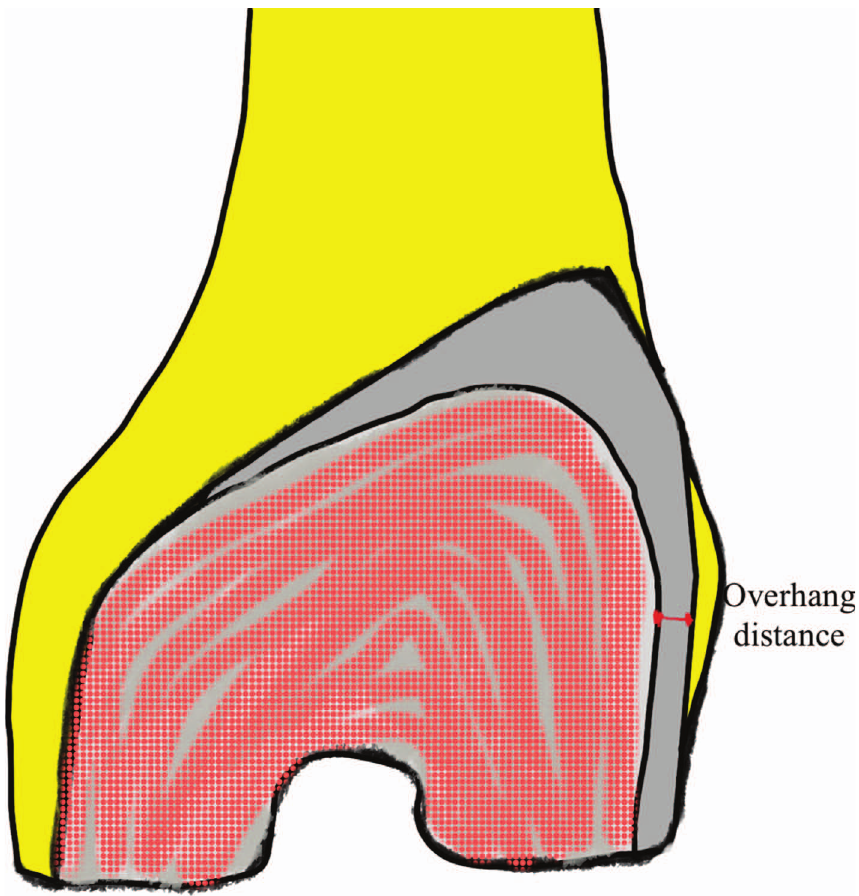
Figure 1. Lateral overhanging of the femoral component was measured intraoperatively. The maximum distance between the lateral edge of the femoral component and lateral bone cut edge was measured twice by the surgeon and